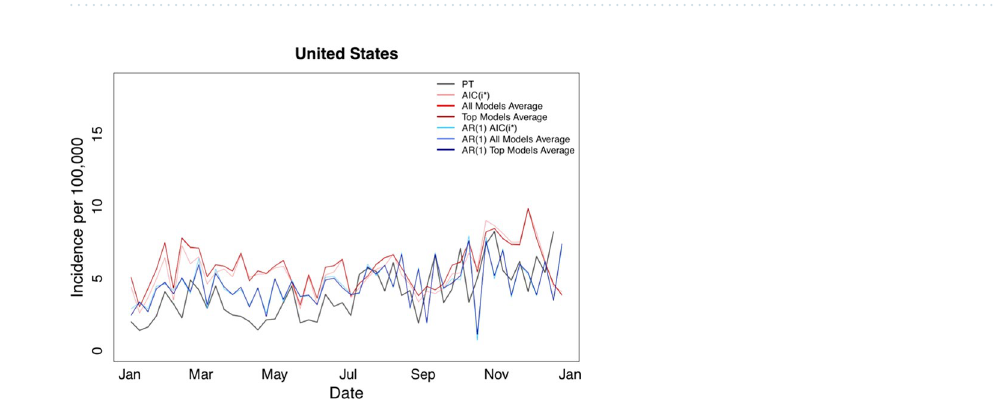
): lowest AIC model, All *